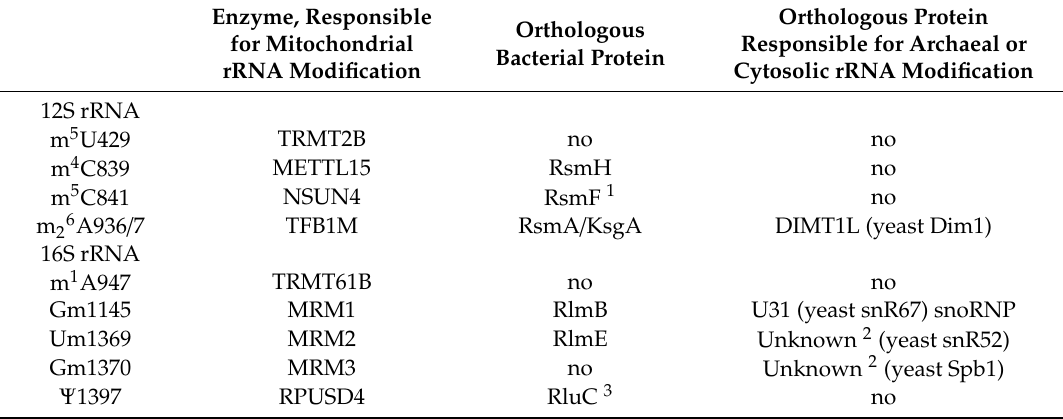
Table 1. EnzymesresponsibleforthemodificationofmammalianmitochondrialrRNA(humannumbering). Enzyme, Responsible Orthologous Protein Orthologous for Mitochondrial Responsible for Archaeal Bacterial Protein rRNA Modification